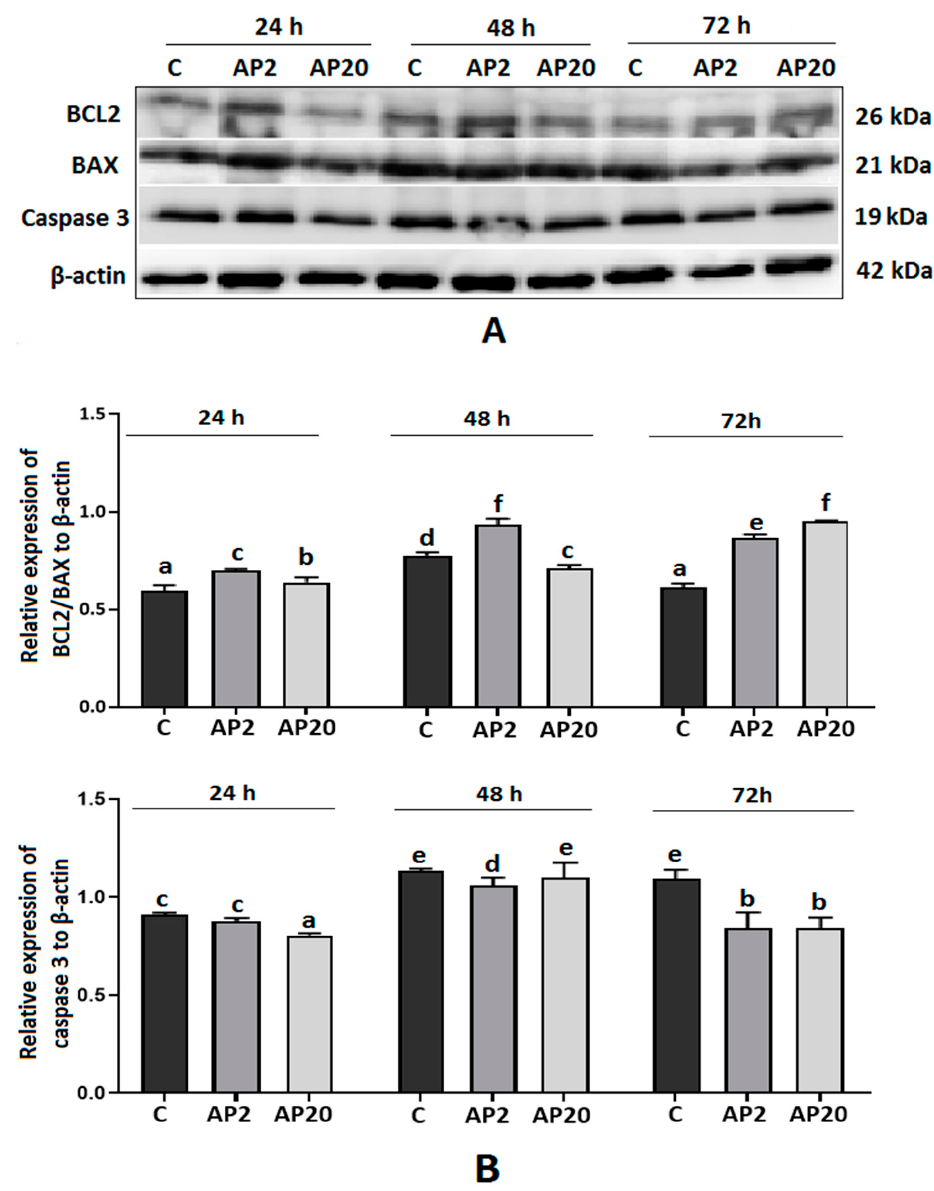
Figure 6. Effect of apelin on protein expression of apoptotic proteins in villous explants from human placenta. The explants were incubated with 2 (AP2) and 20 (AP20) ng/mL of apelin for 24, 48 and 72 h, and Western blot analysis was performed to determine the expression of BCL2, BAX and caspase 3. Results are shown as stripes on gel image ( A ) and densitometry analysis relative to β -actin ( B ). Experiments were performed on five independent cultures of human placenta explants ( n = 5). The data are arranged as means ± SEM. Different letters indicate significant differences ( p < 0.05) among groups; Control